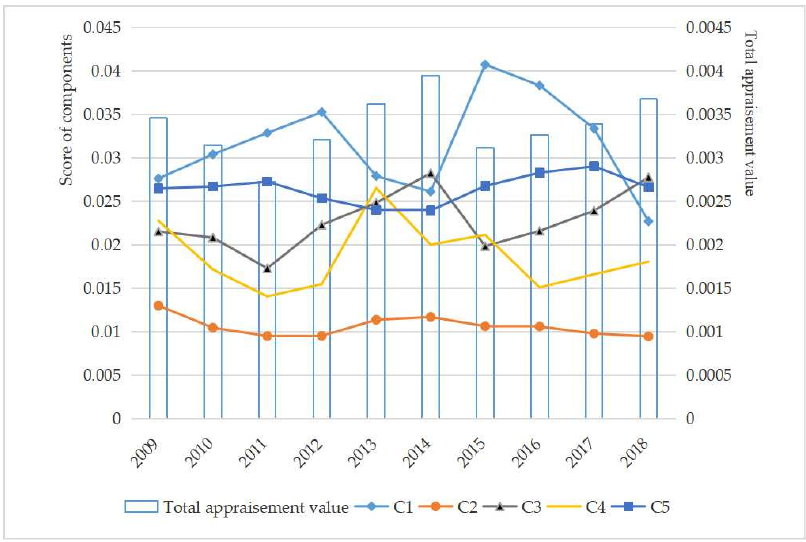
Figure 4. Trends in the ecological development level in the forestry